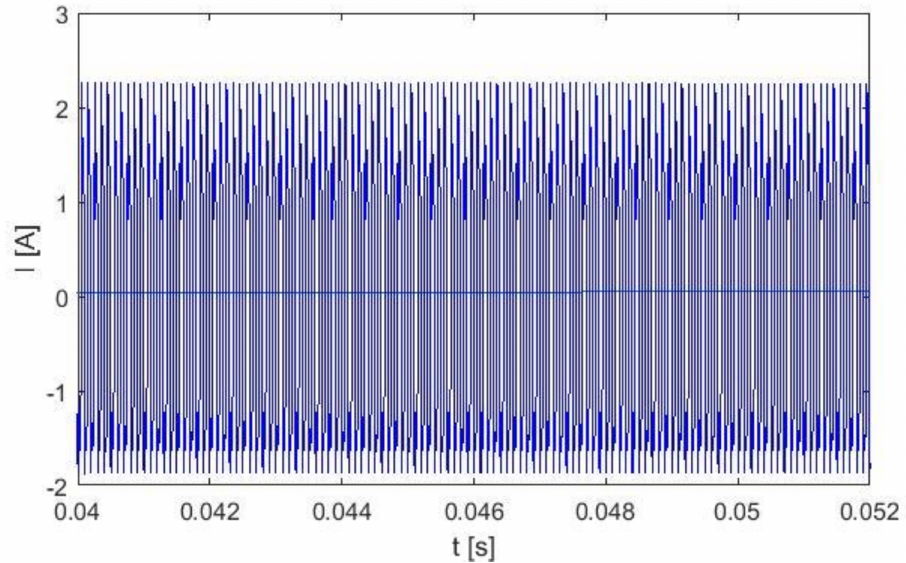
Figure 13. Current waveform between the Graetz bridge and